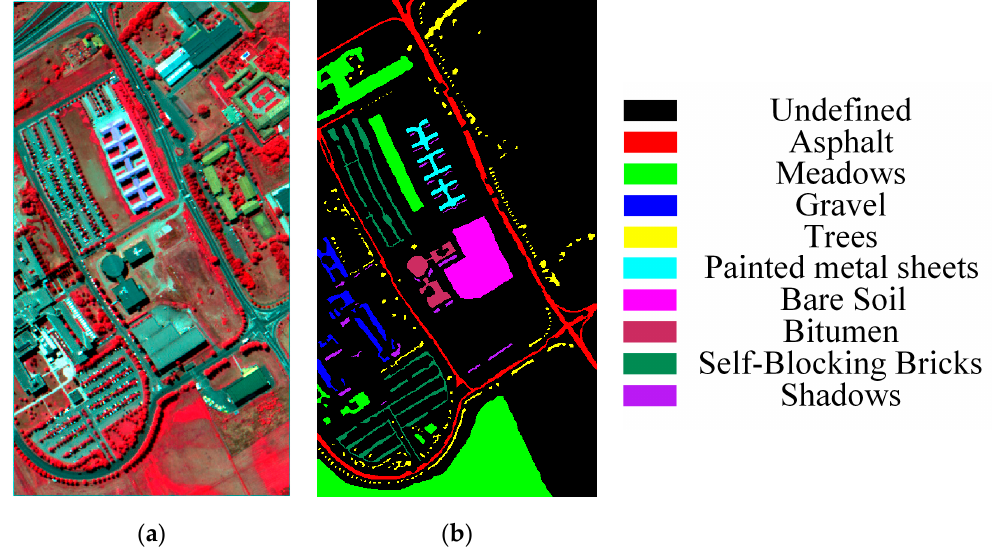
Figure 5. University of Pavia dataset: ( a ) false-color composite of the University of Pavia, ( b ) ground-truth map.